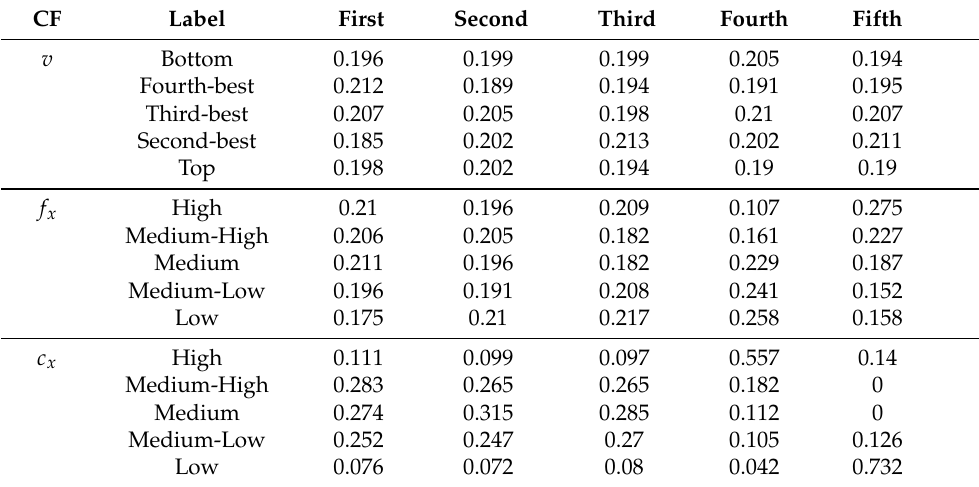
Table 6. Conditional probabilities of time execution given the smart contracts features and miners’